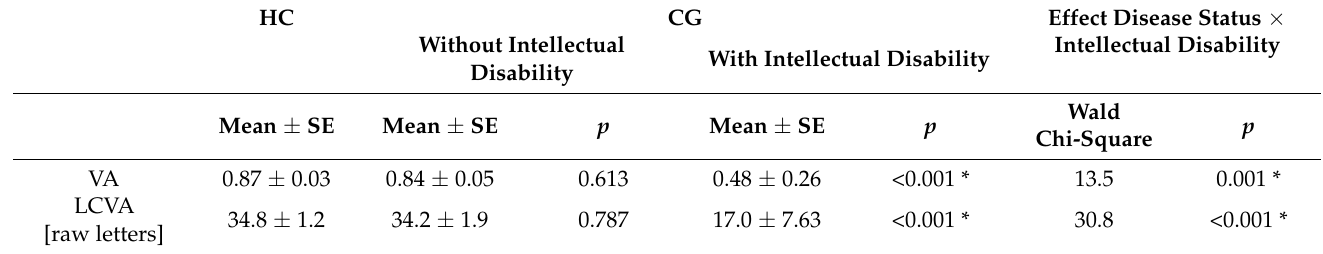
Table 4. Visual acuity of classical galactosemia patients compared to healthy